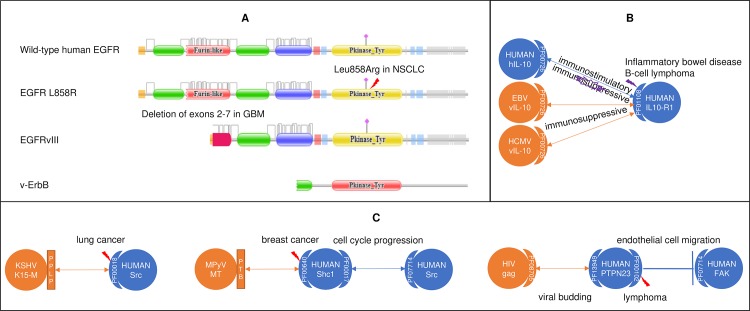
Viral and mutational perturbations of host domains are mechanistically similar.(A) Viruses encode homologues of human proteins to mimic mutations in oncoproteins that cause uncontrolled cell proliferation. Top: EGFRvIII deletion mutation, frequently detected in glioblastoma multiforme (GBM) patients, and v-ErbB, encoded by avian leukosis virus, both lack the EGFR ligand-binding domain. Meanwhile, an L858R missense mutation in the EGFR kinase domain is frequently found in non-small-cell lung cancer (NSCLC). These alterations lead to conformational changes that result in ligand-independent, constitutive kinase activity [61, 62]. (B) Viruses encode homologues of human proteins to antagonize mutations in cytokine receptors that cause hypersensitivity. Human IL-10 functions both as an immunosuppressant in the inhibition of proinflammatory cytokines, and as an immunostimulant in the induction of MHC II expression on B cells. Mutations in the IL10-binding domain of IL-10R1 abrogate hIL10-induced phosphorylation, leading to loss of immunosuppression and inflammatory bowel disease [63]. In contrast, viral IL-10 homologues encoded by Epstein-Barr virus (EBV) and human cytomegalovirus (HCMV) retain and amplify the immunosuppressive properties of hIL-10, thus facilitating viral persistence after lytic infection [64]. ebvIL-10 selectively retains only the immunosuppressive properties of hIL-10. cmvIL-10 binds with greater affinity to IL-10R1 than hIL-10, while co-opting other IL10-associated pathways to amplify the immunosuppressive properties of hIL-10. Interestingly, transgenic expression of vIL-10 has been tested in animal models as an immunosuppressant option for transplant recipients [65]. In addition, abnormal expression levels of IL-10, IL10-R1 and IL10-R2 has been suggested as a mechanism for diffuse large B-cell lymphoma, a disease with clear EBV involvement [66]. (C) Viruses abuse peptide motifs to modulate host signaling pathways, potentially mimicking the effects of disease-causing mutations. Left: Kaposi’s sarcoma-associated herpesvirus (KSHV) protein K15-M uses a “PPLP” motif to bind the SH3 domain (PF00018) of Src [67], which possibly induces conformational opening of the Src kinase domain, thereby mimicking activating mutations such as Y527F [68]. Interestingly, a W121C mutation in the KSHV-targeted SH3 domain of Src has been identified in lung cancer [69]. Middle: Murine polyomavirus (MPyV) Middle T antigen (MT) uses a tyrosine-phosphorylated motif to recruit host Shc1, thereby promoting cell cycle progression [70]. Interestingly, a R175Q mutation in the MPyV-targeted PTB domain (PF00640) of Shc1 has been found to regulate tumorigenesis in mouse models of breast cancer [71]. Right: HIV protein gag uses the late-budding domain to sequester host PTPN23 and facilitate viral budding [72]. The phosphatase domain (PF00102) of PTPN23 regulates cell migration via dephosphorylation of FAK and is often mutated in cancer and developmental disorders [73, 74].